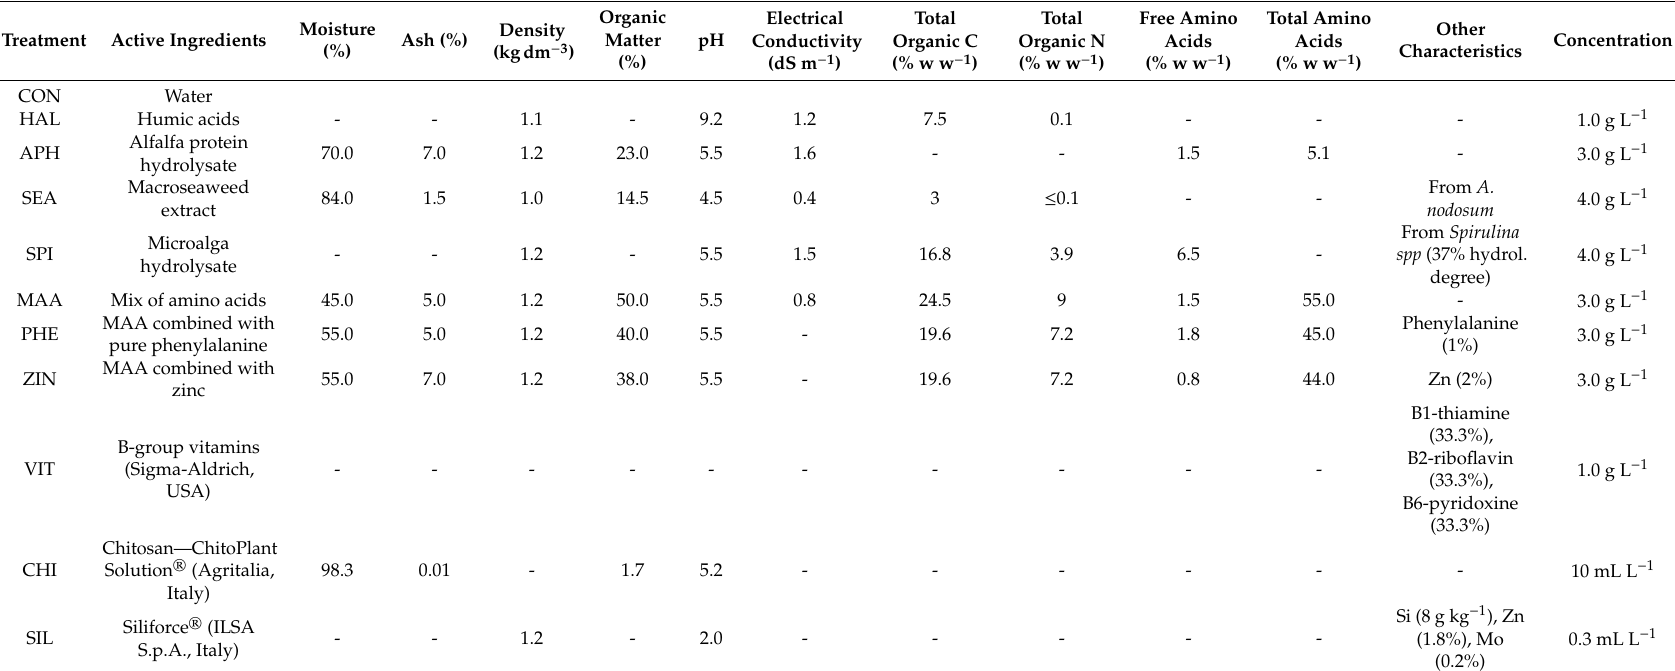
Table 3. Biostimulant characterization, properties, and concentration applied for the